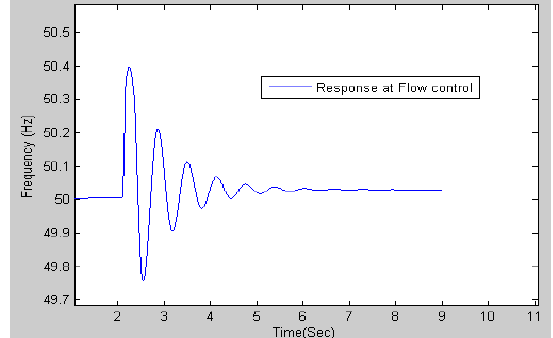
Fig. 11. Response of SHP System for Flow Control Scheme